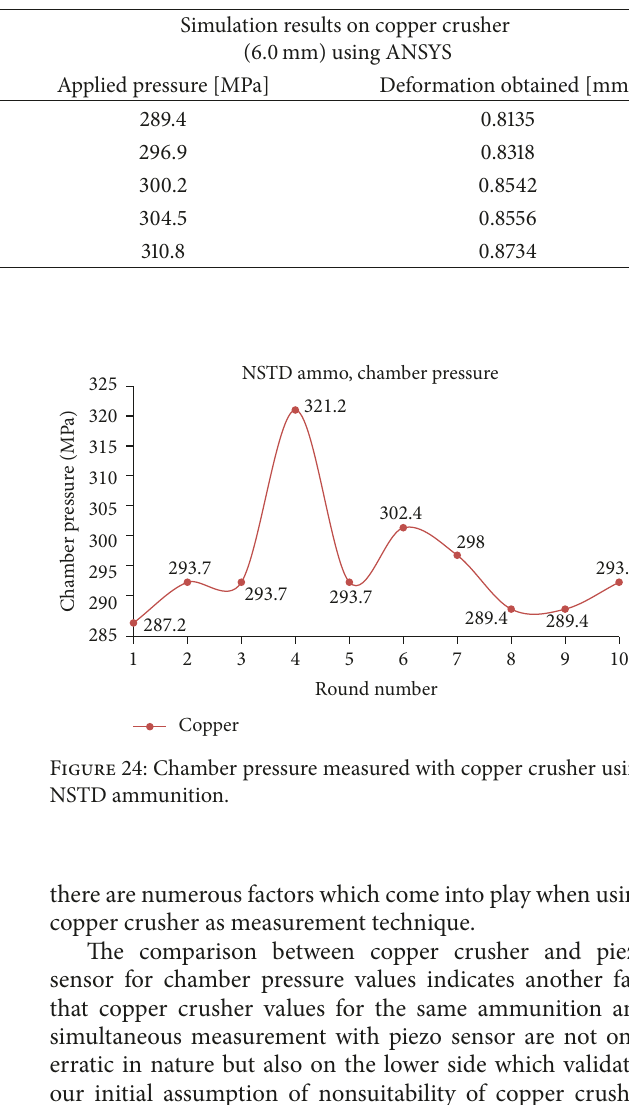
Table 8: Pressure results validation on ANSYS (cid:2) workbench.